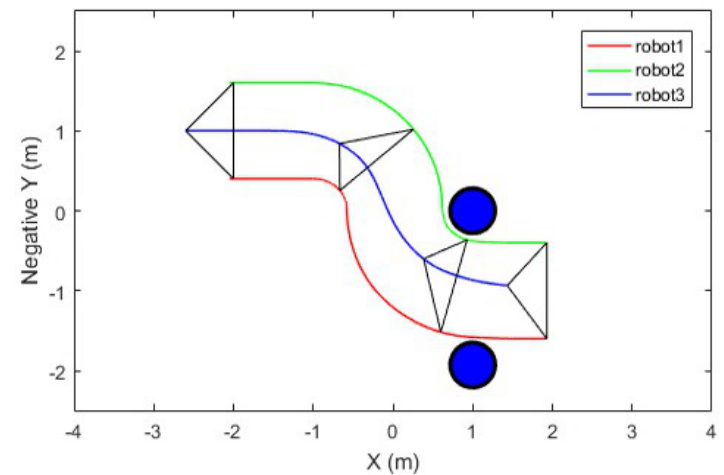
Figure 7. The formation tracking performance for robots in formation with C1.